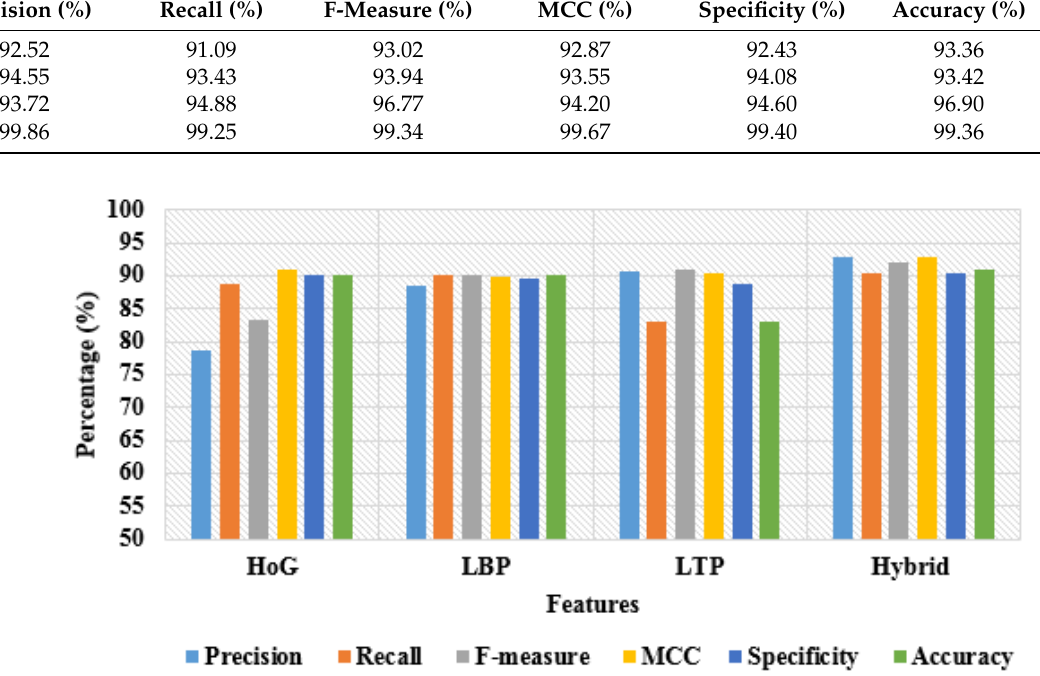
Figure 11. Graphical comparison of dissimilar features with 50% training and 50% testing of data.